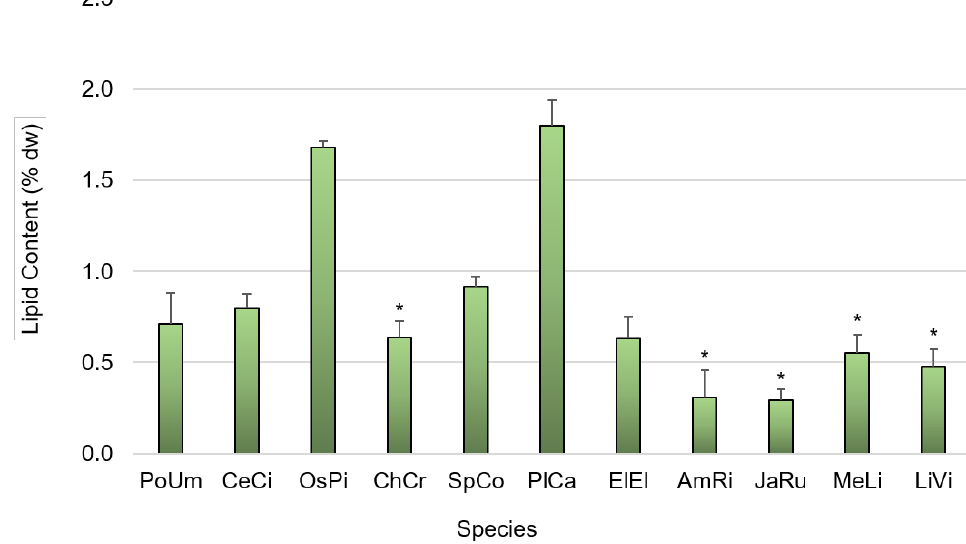
Figure 4. Lipid content of the eleven studied red seaweed species expressed in % of dry weight. PoUm: Porphyra umbilicalis , CeCi: Ceramium ciliatum , OsPi: Osmundea pinnatifida , ChCr: Chondrus crispus , SpCo: Sphaerococcus coronopifolius , PlCa: Plocamium cartilagineum , ElEl: Elisolandia elongata , AmRi: Amphiroa rigida , JaRu: Jania rubens , MeLi: Mesophyllum lichenoides , LiVi: Liagora viscida . Values are presented as means ± SD ( n = 3), and asterisks (*) indicate statistically significant dif- ferences between the species with the highest lipid content (PlCa) and all other remaining species (Kruskal–Wallis test ( χ 2 (10) = 28.848; p =